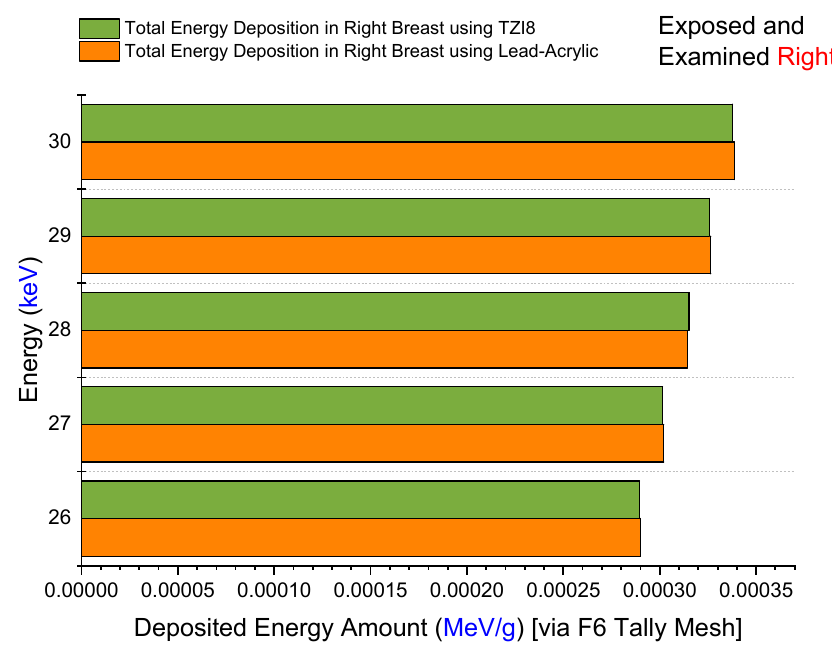
Figure 8. Variation in deposited ‐ energy amount in exposed right breast.